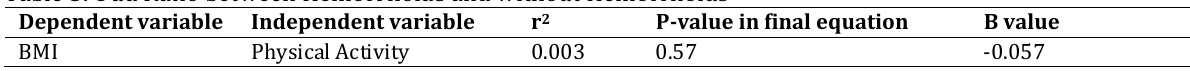
Table 3. Odd Ratio between Hemorrhoids and without